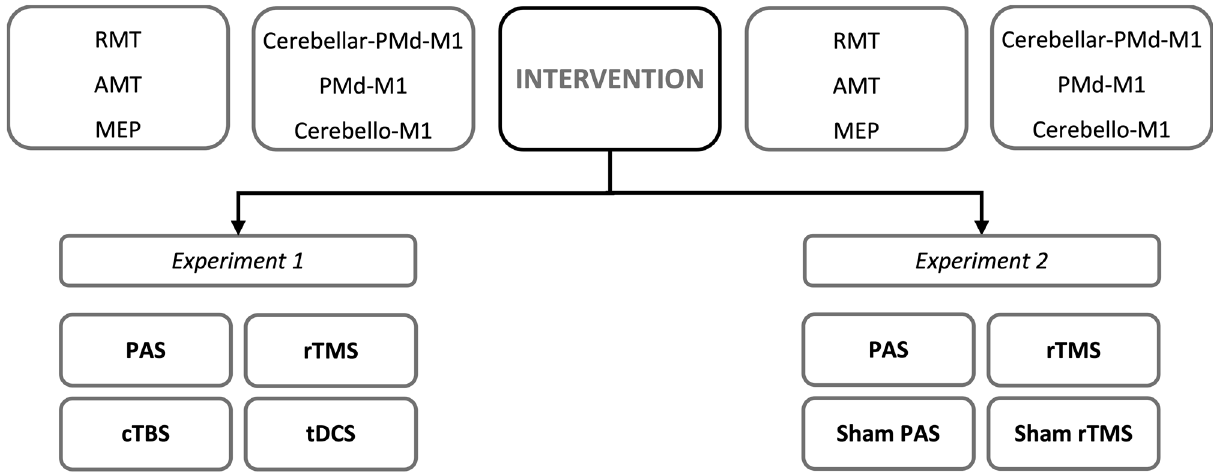
Figure 1. Study design. Probands were investigated in experiments 1 or 2 using four separate sessions with one of the four different plasticity intervention. Before and after the intervention the same single- and multi-pulse TMS paradigms were applied. RMT resting motor threshold, AMT active motor threshold, MEP motor evoked potential, PMd dorsal premotor cortex, M1 primary motor cortex, PAS paired associated stimulation, rTMS repetitive transcranial magnetic stimulation, cTBS continuous theta-burst, tDCS transcranial direct current